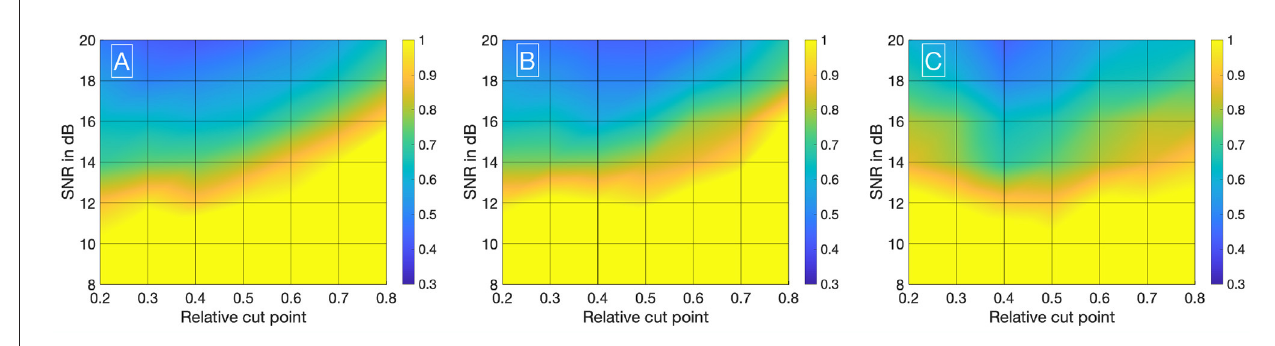
FIGURE 11 | (A) Mean ε frames using the gamma variate model on the data sets ( f sampling obtain the transit time, the cross-correlation is computed. (B) Mean ε frames using the LDRW model on the data sets ( f sampling method 3 is applied to the data set. To obtain the transit time, the cross-correlation is computed. (C) Mean ε frames using the LDRW model on the data sets ( f sampling 60 Hz ). Before fitting the model, cut method 1 is applied to the data set. To obtain the transit time the cross-correlation of the first derivative is =